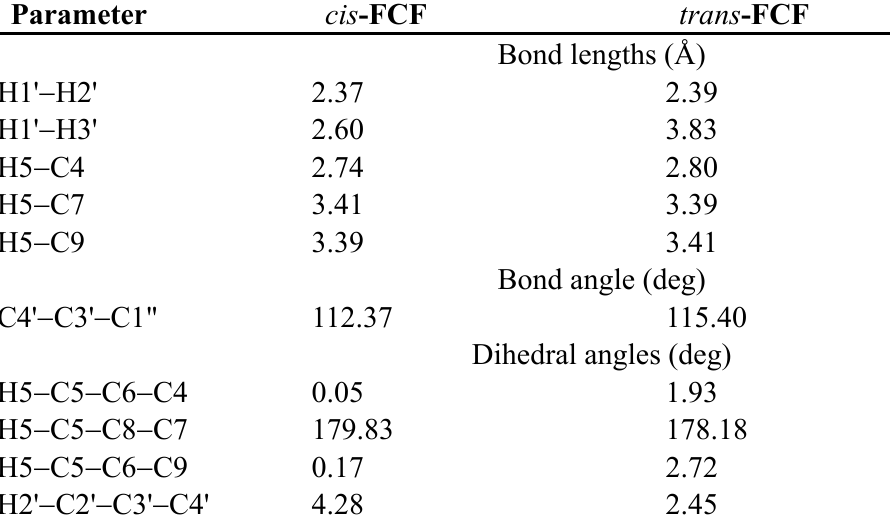
Table 3. Geometrical parameters determined for cis - and tran s-flocoumafen using the B3LYP 6-31G ** basis